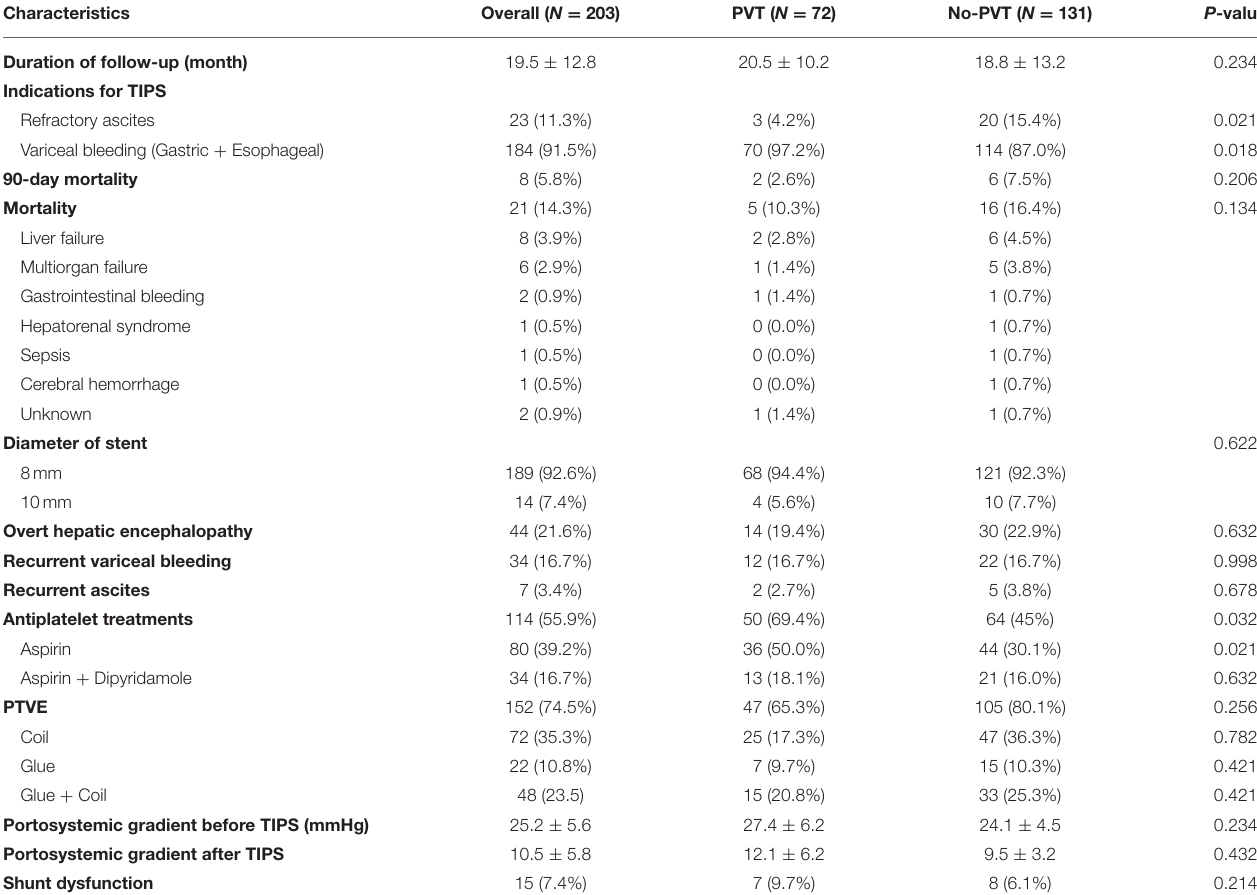
TABLE 2 | Outcomes of Transjugular intrahepatic portosystemic shunt in the Entire Cohort. Characteristics Overall ( N =